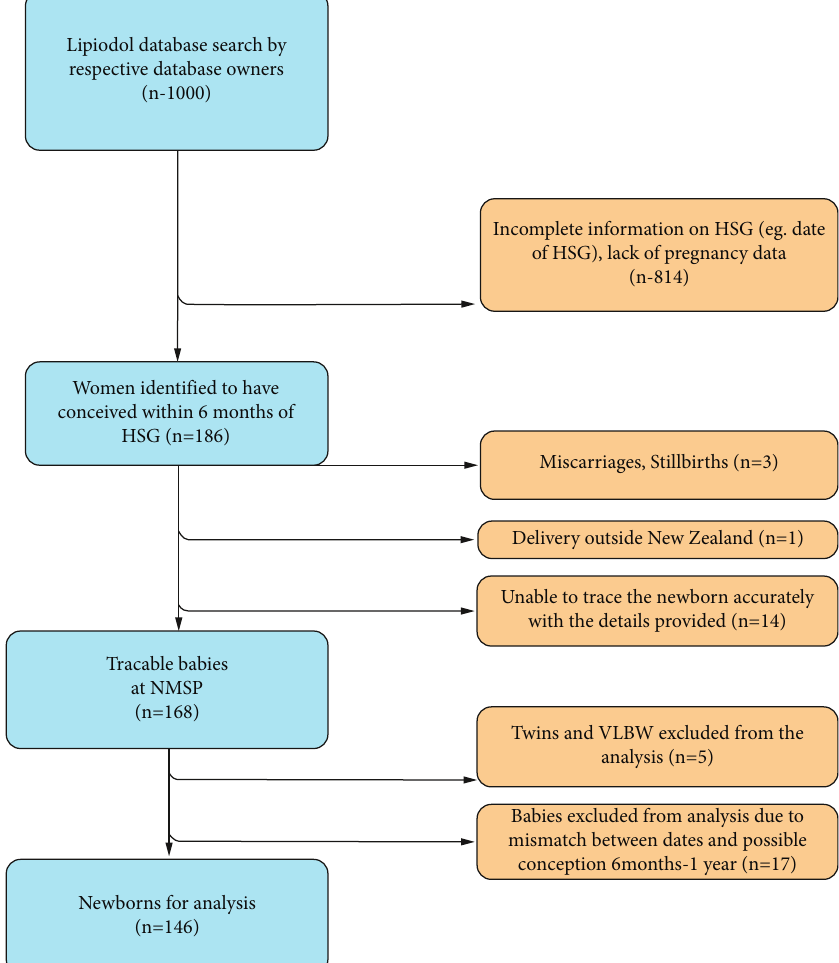
Figure 1: Flowchart for the identification of newborns conceived following OSCM HSG and the neonates included in the analysis of TSH data. HSG, hysterosalpingogram; NMSP, newborn metabolic screening program; VLBW, very low birth weight.